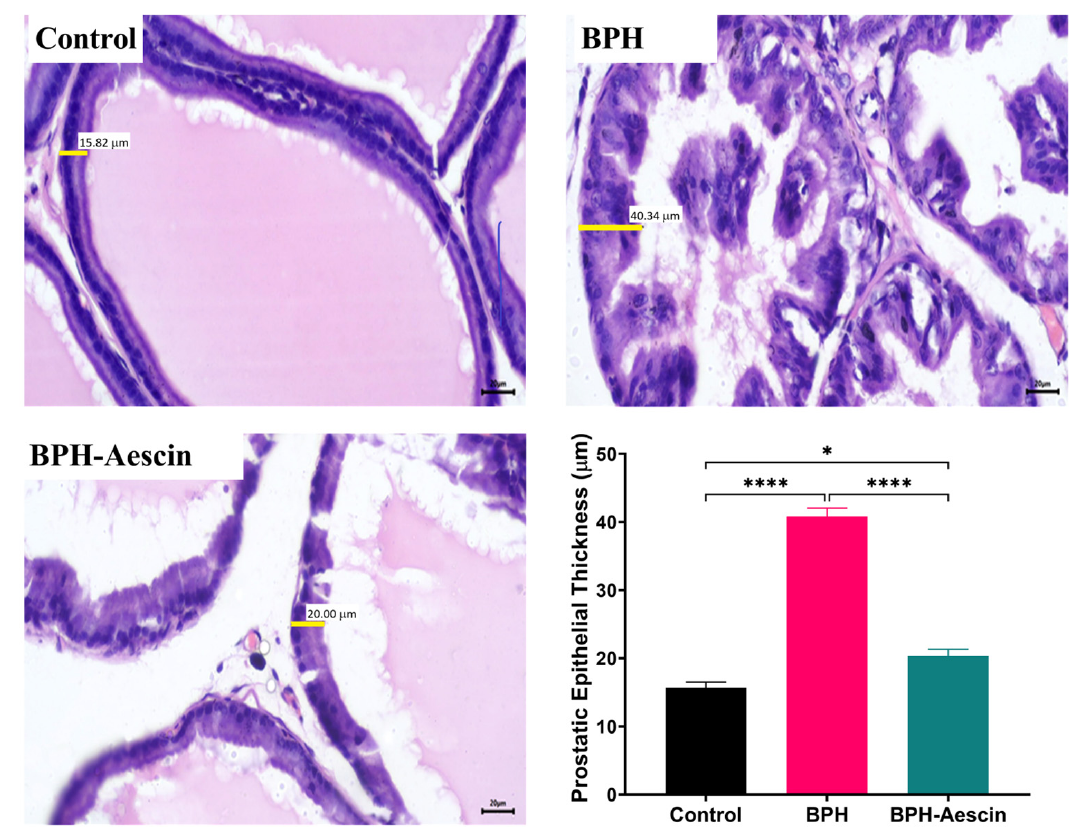
Figure 3. Aescin abrogates the testosterone-induced epithelial thickening in the prostate. Sections of rat prostate stained with Hematoxylin–Eosin from the control, BPH, and BPH rats treated with aescin (10 mg/kg, p.o.) for 4 weeks are shown (400 × ). The representative photomicrographs show the thickness (yellow bars) of prostate glandular epithelium among the different studied groups. The bar graph in the lower-right corner shows the analysis of prostatic epithelial tissue thickness measurements. Data (Mean ± SEM, n = 5) were analyzed by one-way ANOVA followed by Tukey’s multiple comparisons test. * and **** denote significant differences between the selected study groups at p values < 0.05 and 0.0001,